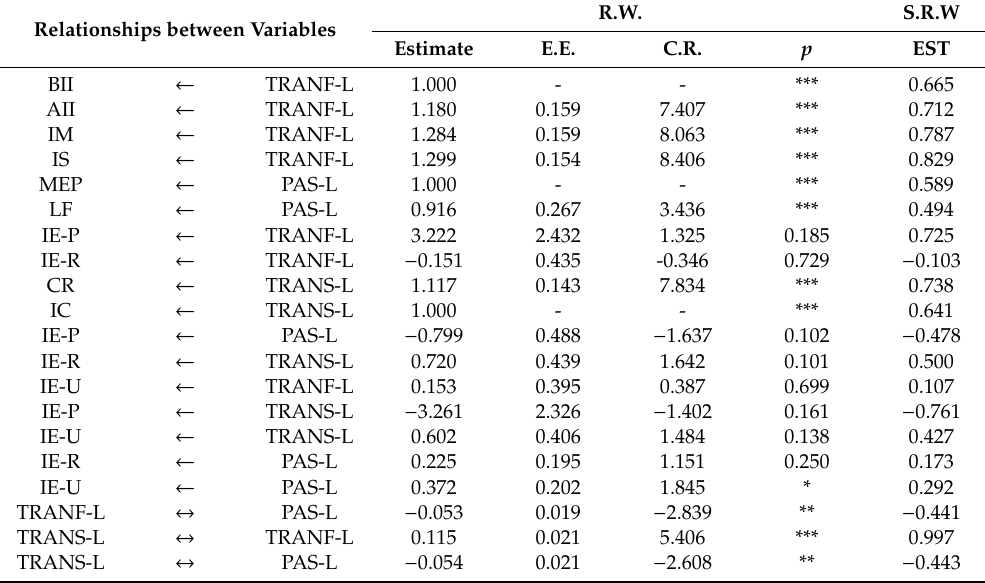
Table 3. Regression weights and standardized regression weights for university teaching. R.W. S.R.W Relationships between Variables Estimate E.E.